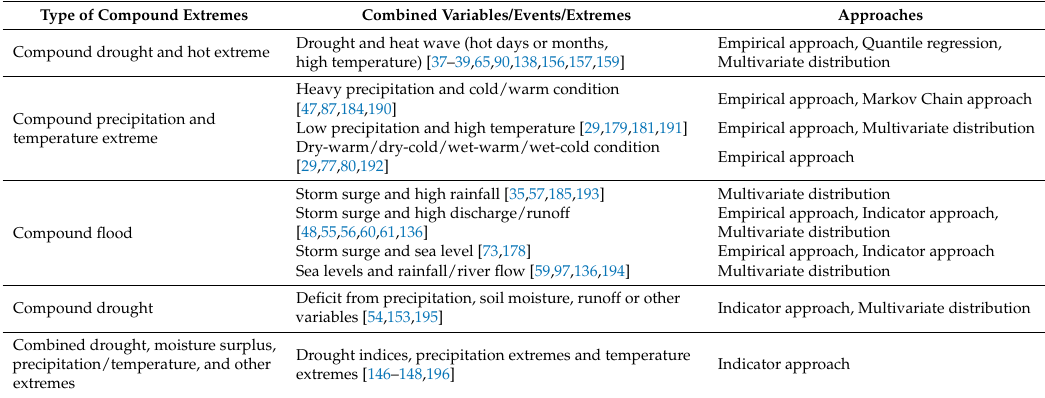
Table A1. Summary of Different Types of Compound Extremes and Statistical